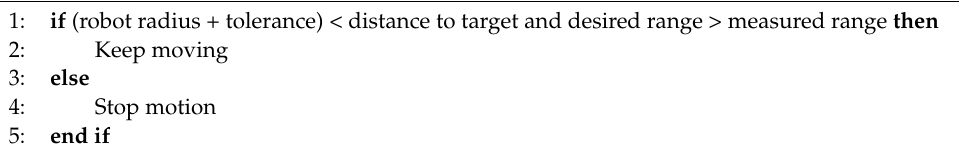
Figure 10. Obstacles in the work area.